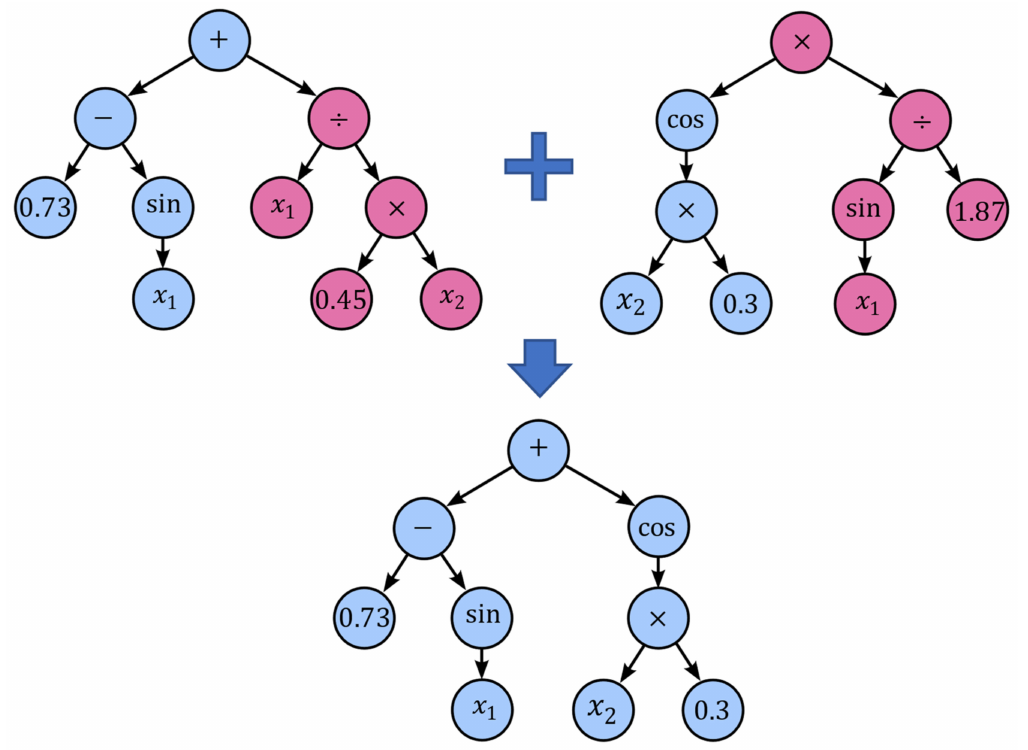
Figure 10. Crossover.